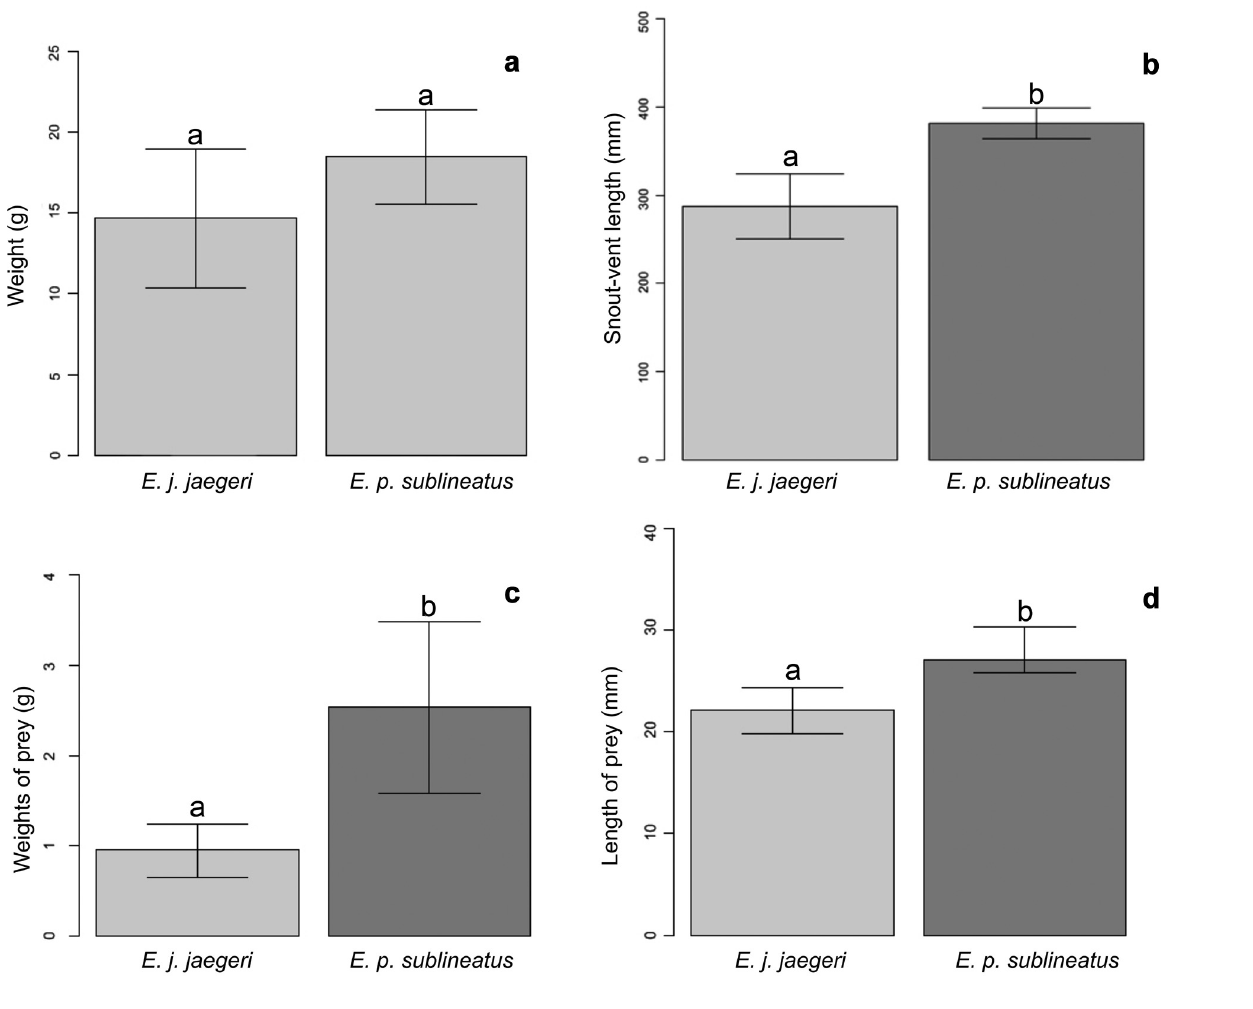
Figure 1 - Means ± standard deviation of weight (in grams) ( a ) and snout-vent length (SVL) (in millimeters) ( b ) of Erythrolamprus jaegeri jaegeri and Erythrolamprus poecilogyrus sublineatus in the present study; means ± standard deviation of weights (in grams) and total length (in millimeters) of prey found in digestive tracts of the snakes are presented in the fi gures c and d ,